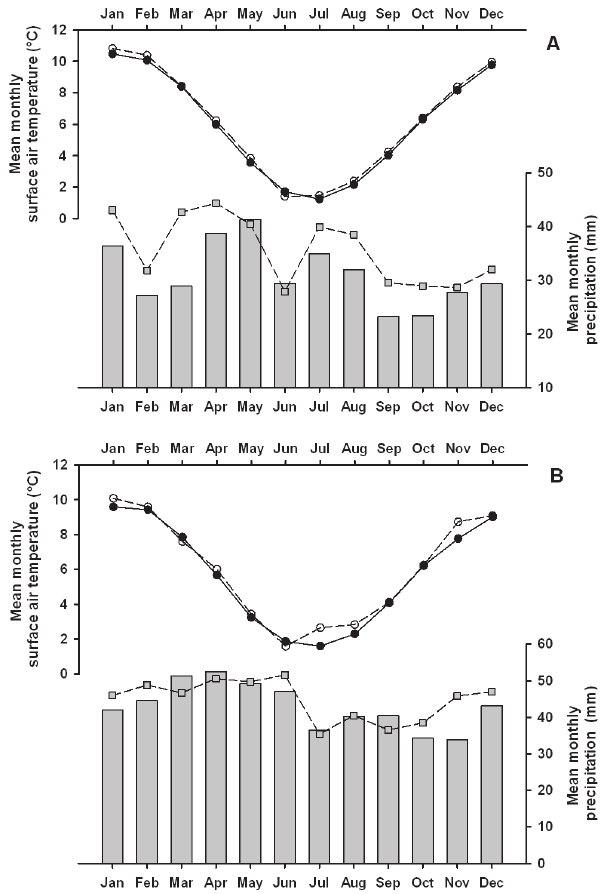
Fig. 2. Mean monthly surface air temperature (MMT; closed circles) and precipitation values (MMP; grey bars) for 1961–1990 at Punta Arenas (A) and Ushuaia (B) , compared with MMT (open circles) and MMP (grey squares) for 1981–2010 (see Table 1 for n-values). Fig. 3. Modern isotopic and climate data from Global Network